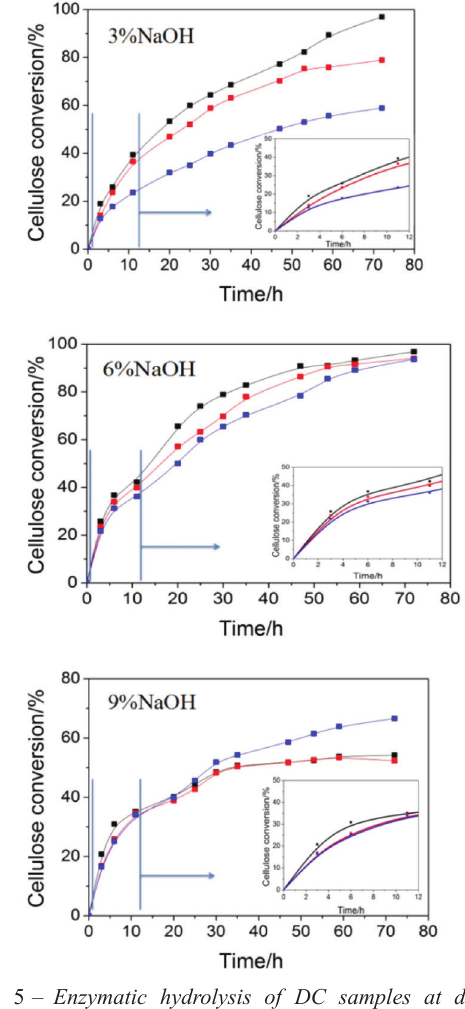
Fig. 5 – Enzymatic hydrolysis of Dc samples at different steam explosion severities of 3.05 (black), 3.45 (red) and 3.64